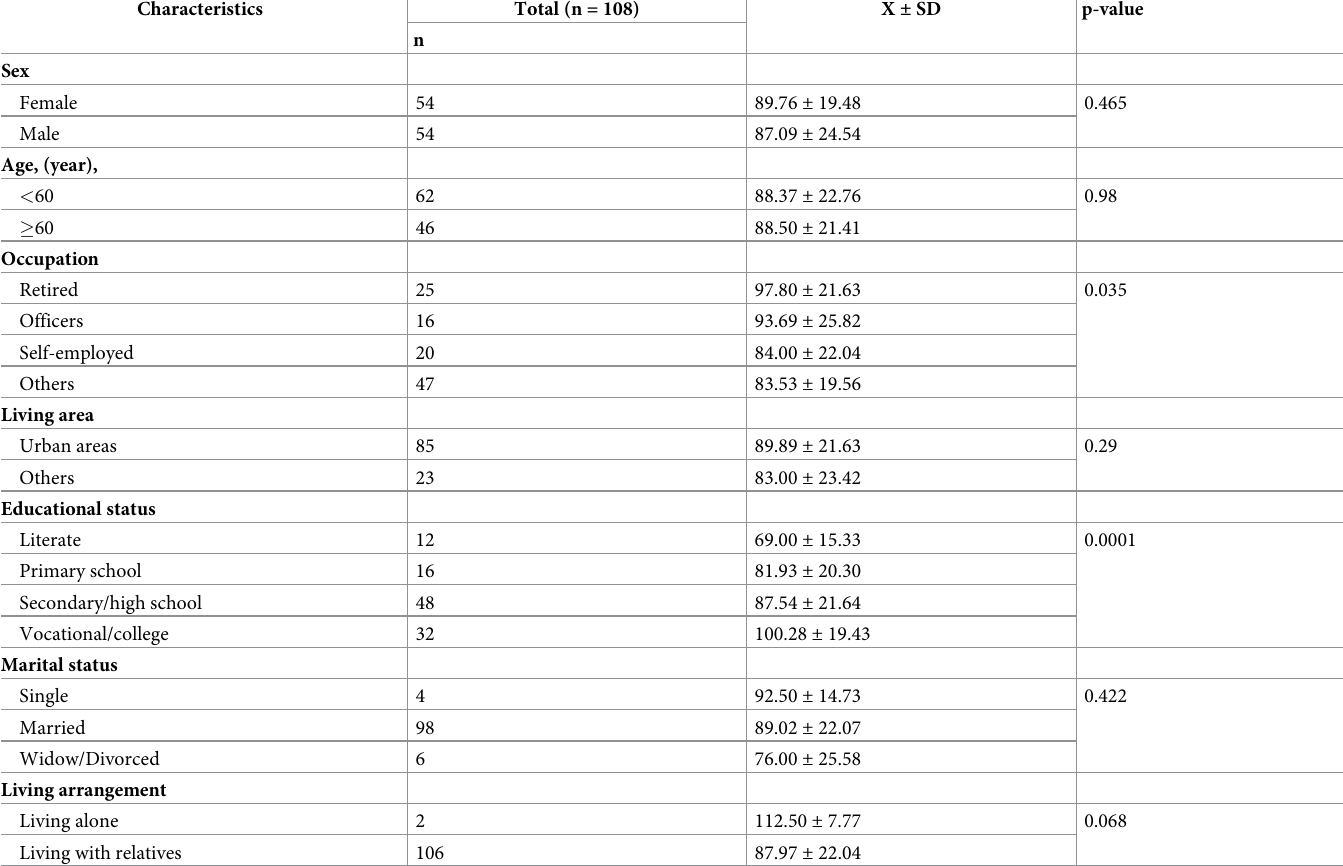
Table 3. The mean total DSMI scores across groups by socio-demographic characteristics.